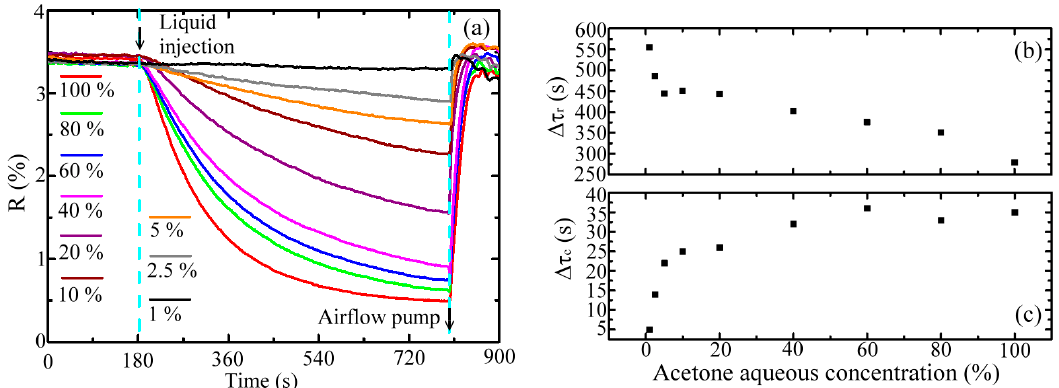
Figure 7. ( a ) Dynamic reflectivity of a WGS unit at 0.352 THz for various acetone aqueous solutions, and ( b ) response and ( c ) recovery times of the WGS unit.